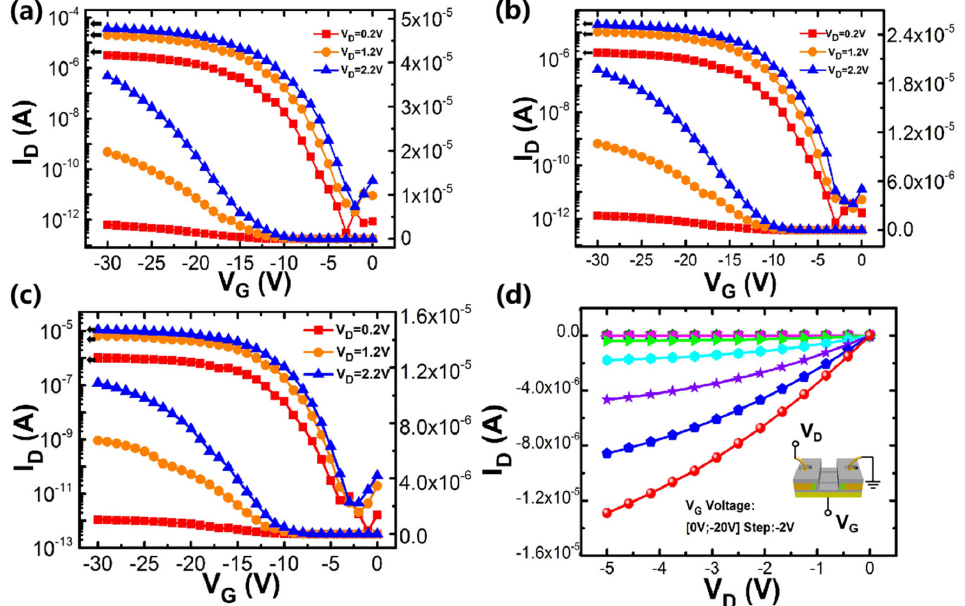
Figure 5. ( a – c ) I D -V G curves of the fabricated 5- μ m-L G , 10- μ m-L G and 15- μ m-L G p-type poly-Si NW sensors by back bias gate voltage, ( d ) typical I D -V D of the fabricated 10- μ m-L G p-type poly-Si NW sensors. NW